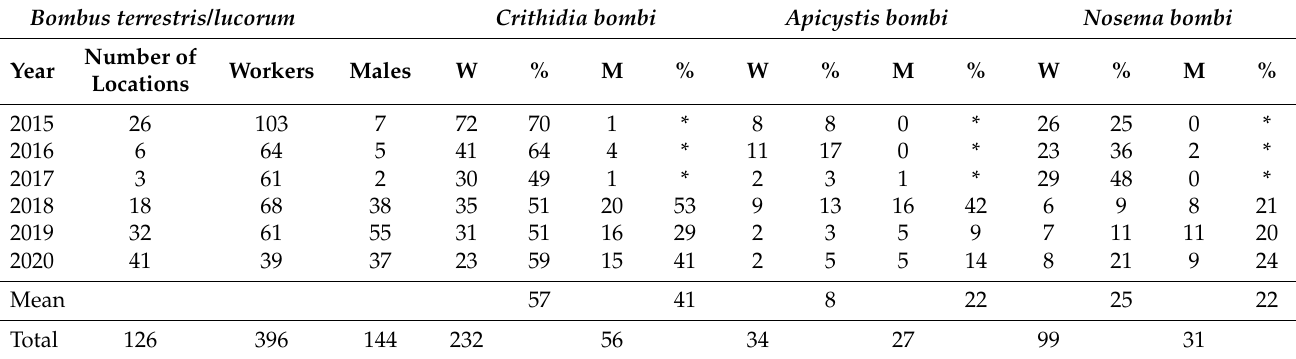
Table 1. Results of laboratory test, obtained by PCR detection for species B. terrestris/lucorum for pathogens C. bombi , A. bombi and N. bombi . W workers, M males, * low number of samples; - not